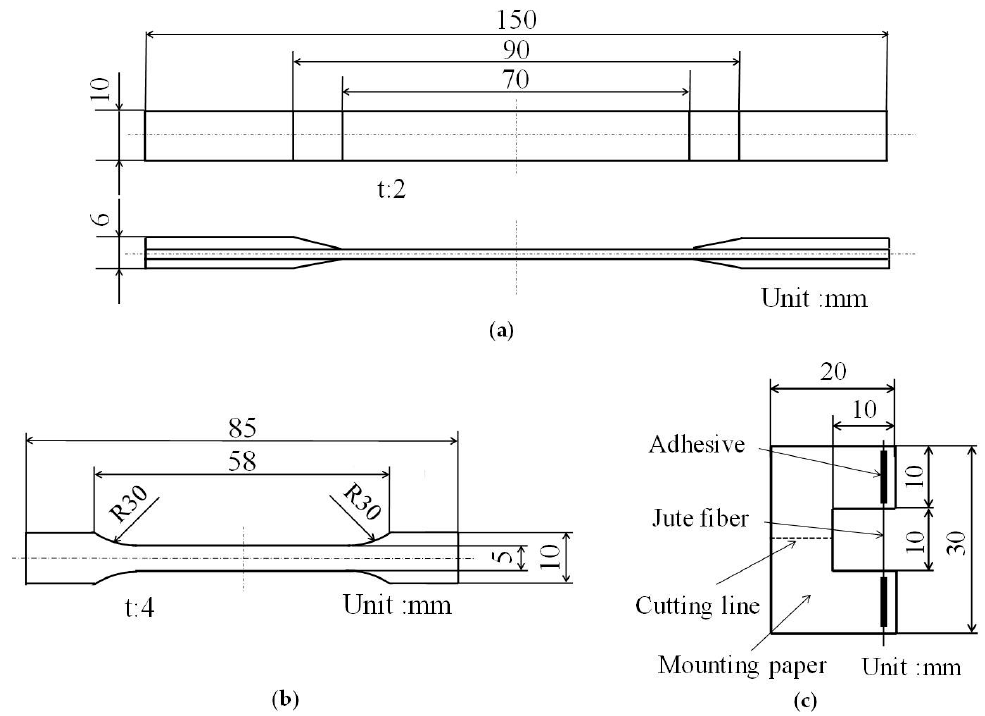
Figure 1. Schematic drawing of specimens: ( a ) Green composite; ( b ) Poly(lactic acid) (PLA); ( c ) Jute fiber.